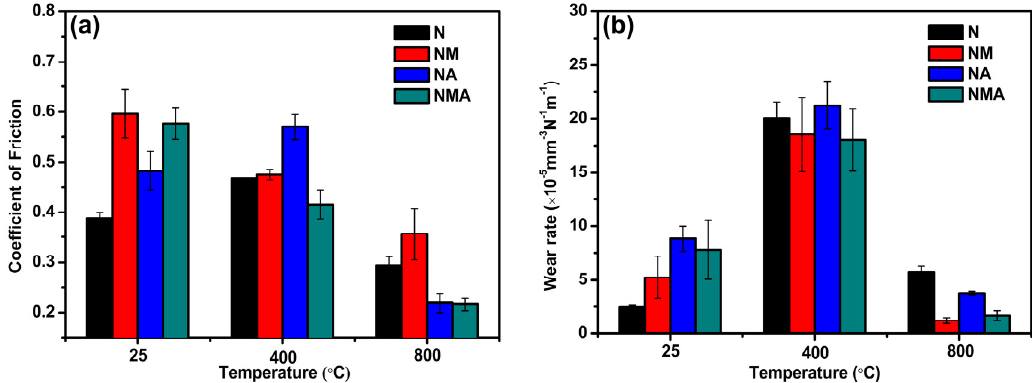
Figure 3. ( a ) Friction coefficients and ( b ) wear rates of Ni-based composites at different temperatures.